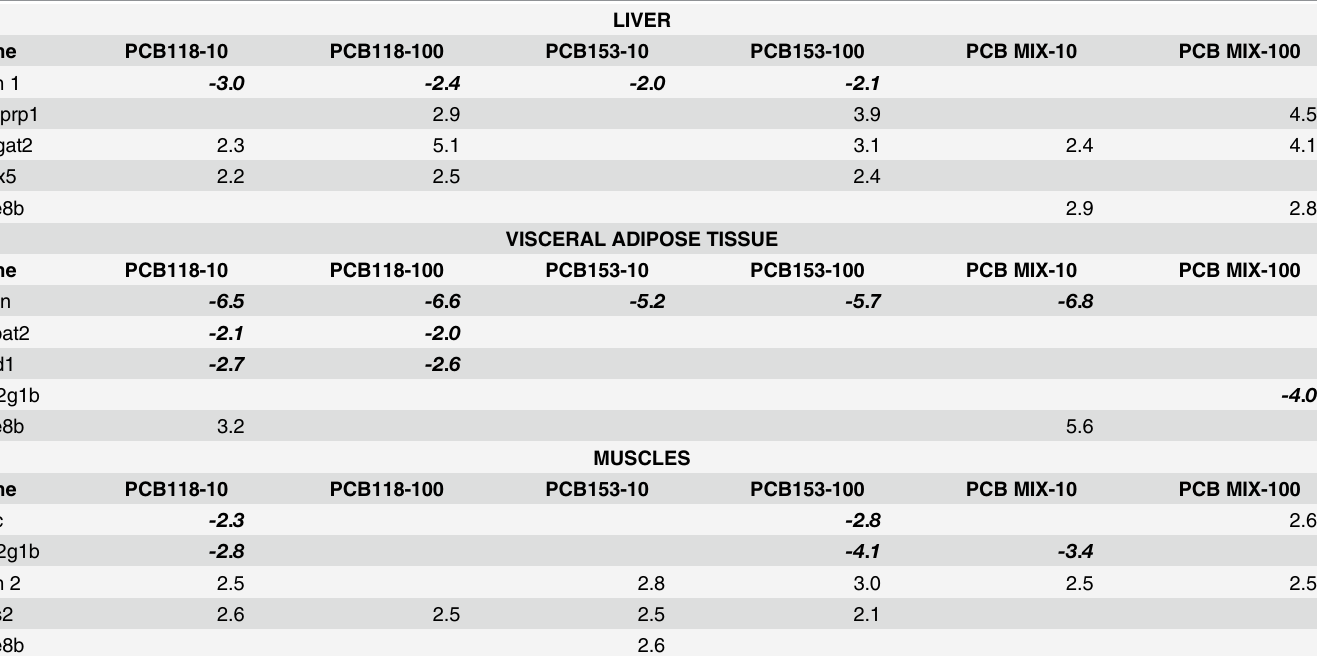
Table 6. Genes involved in lipid homeostasis based on microarray